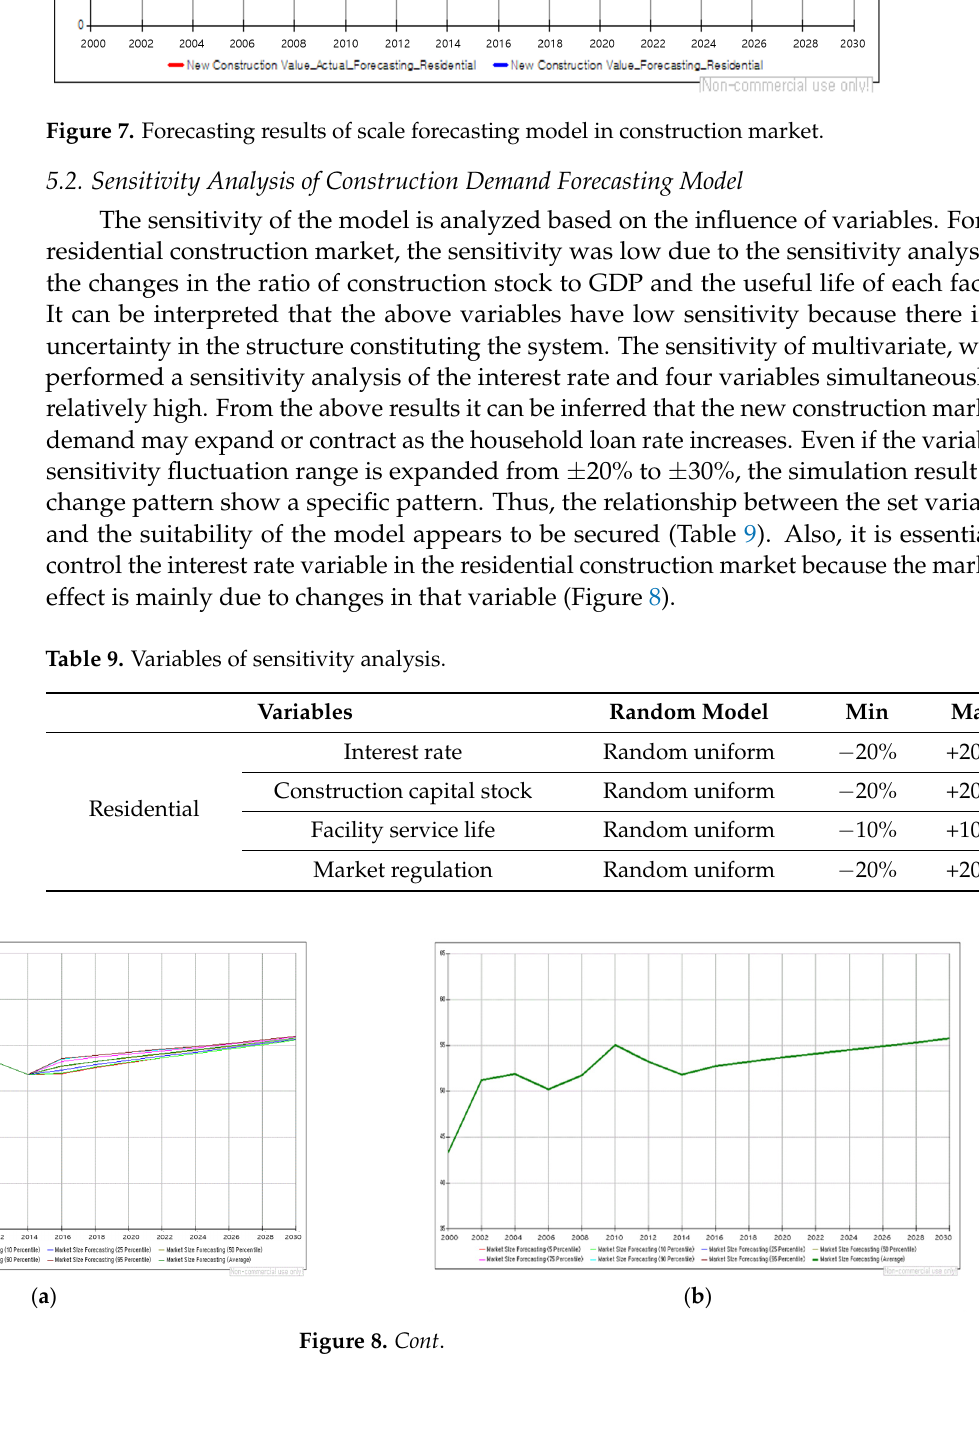
( e ) Figure 8. Analysis of new construction market sensitivity in residential sector. ( a ) Interest rate; ( b ) percentage of construc- tion stock to GDP; ( c ) facilities durable years; ( d ) market regulation; ( e ) multivariate sensitivity. 6. Conclusions The construction market is a vast system composed of many subsystems, dynamic due to the interaction between them. The system has complex system characteristics due to various environmental factors surrounding the construction market and dynamic con- struction paradigm changes. Forecasting the demand for the future construction market is significant because it has a profound effect on overall construction activities. It is not easy to make scientific predictions considering dynamic market trends and environmental changes because various factors affecting the construction market occur in a complicated way. This study aimed to identify how the construction market will change in the long term by developing a model for predicting construction demand. Also, to achieve the model’s usefulness and usability, the factors for the phenomenon are analyzed through simulation.